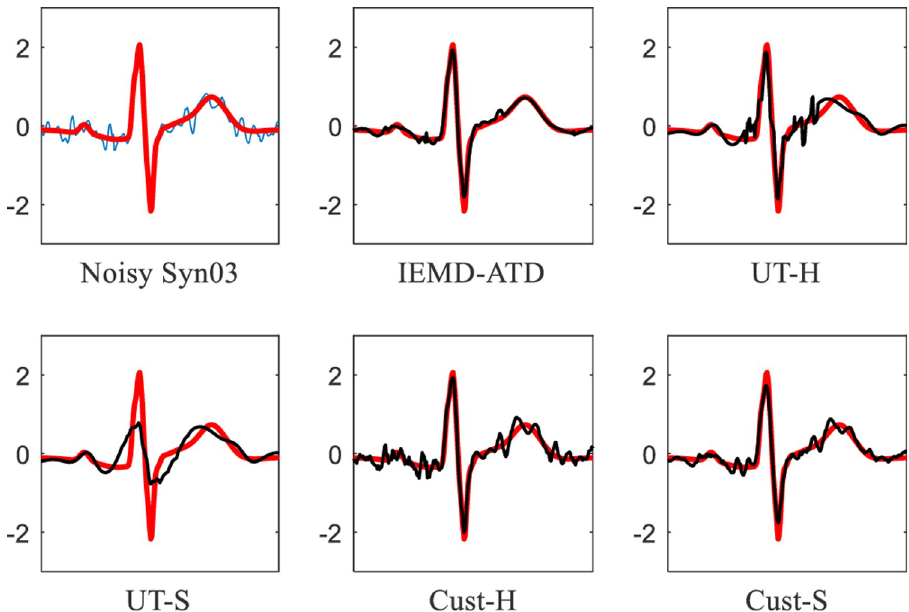
Fig 10. Details of waveforms between 2.4 and 3.05 seconds from Fig